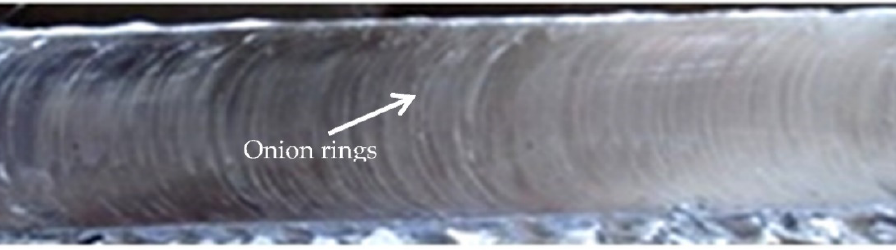
Figure 9. Onion ring-shaped structure.